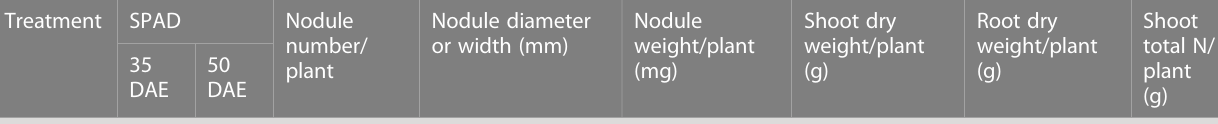
Nodule weight/plant (mg)